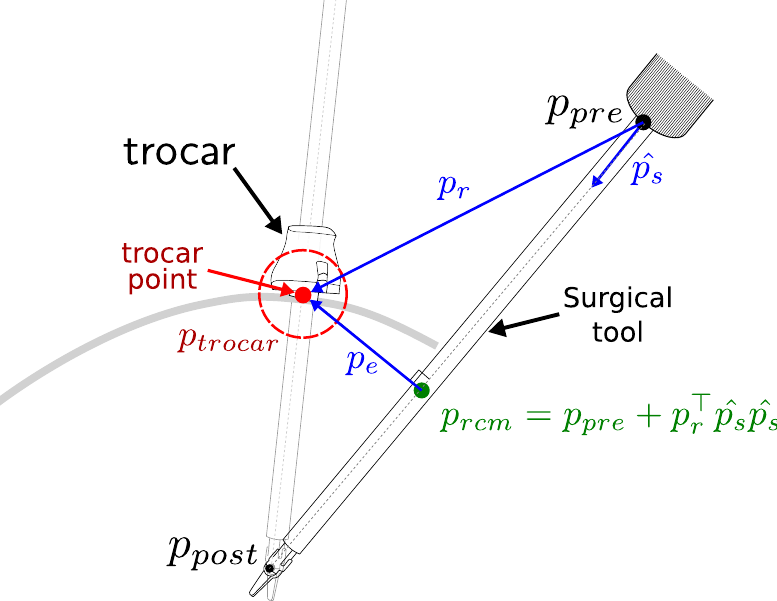
Figure 1. Characterization of the remote center of motion (RCM). The motion of the surgical tool is constrained by the trocar point, resulting in an RCM error, which is defined as the minimum distance between the tool axis and the trocar point e rcm = || p e ||